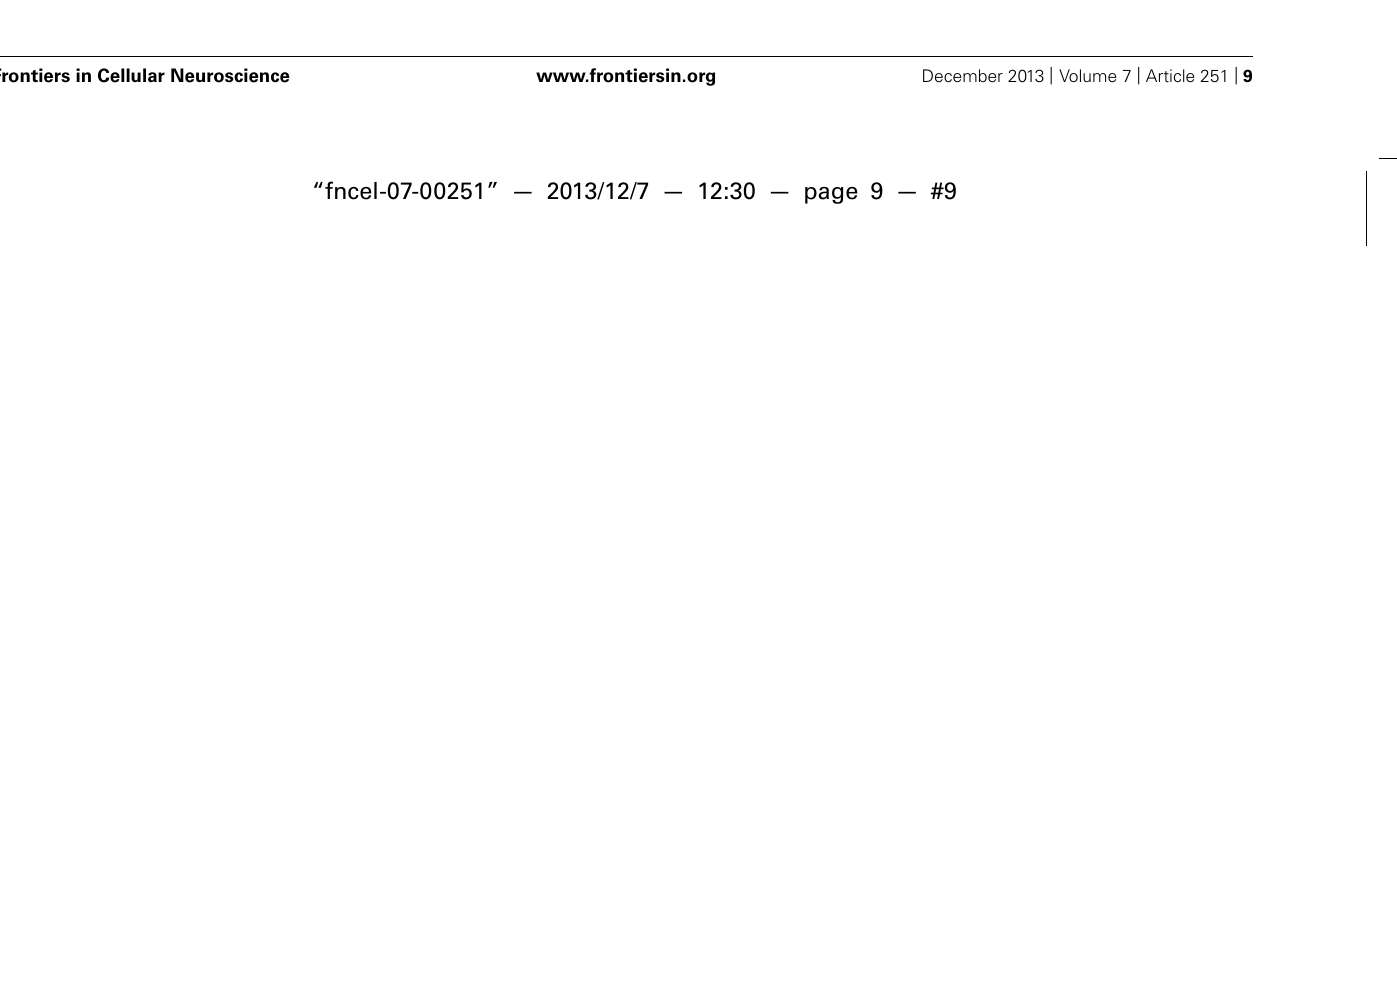
FIGURE 7 | (A–D) subcellular fractionation presented as bar histograms, showing the distribution patterns of glutamate and GABA transporters as a percentage over total signal in all fractions. A leftward shift is observed for EAAT-1 (A) and EAAT-2 (B) . * p < 0.05; ** p < 0.01, sham vs. SNI, t -test with Bonferroni correction for multiple comparisons ( n = 5–6 rats for each